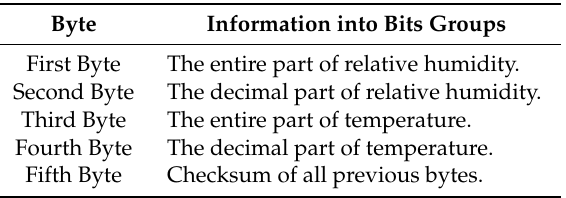
Table 11. Types of sensors for smart city